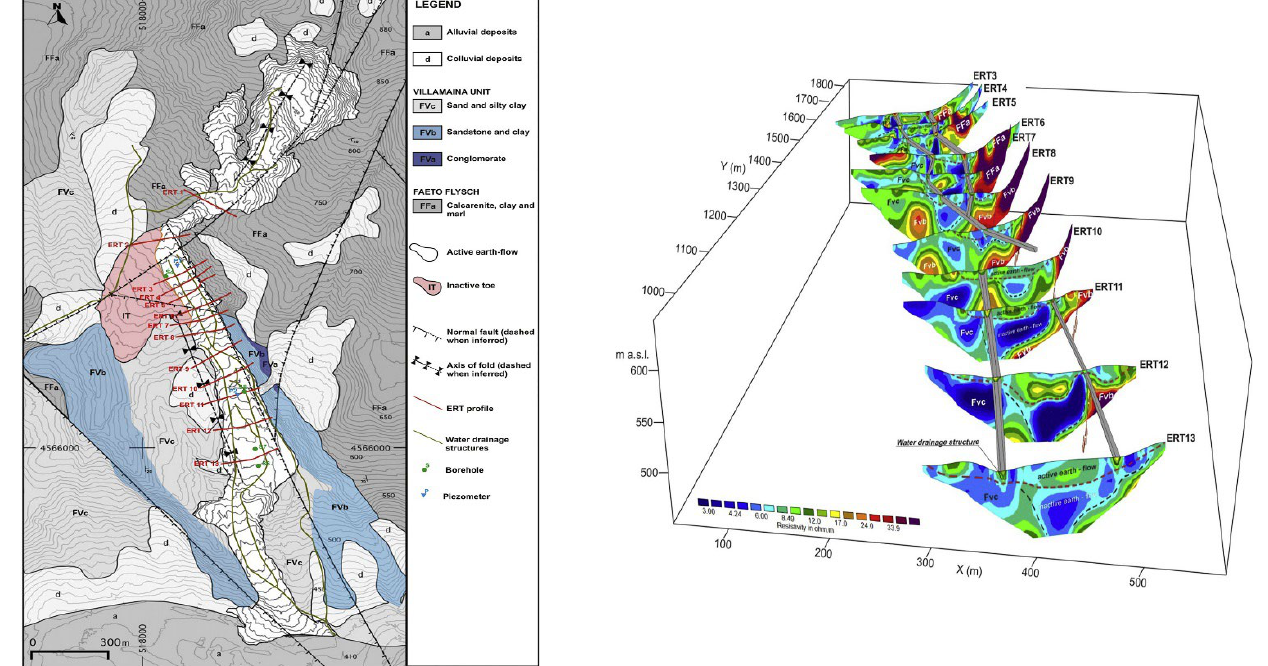
Figure 1. ( Left ) Geological map of the Montaguto earthflow (Campania region, southern Italy) with the location of direct and indirect investigations. Red lines: ERT profiles. Green line: water drainage structures. Green dot: borehole. Blue triangle: piezometers. ( Right ) Fence diagram showing the locations of the 2D ERT (ERT 3–ERT 13) within a 3D space. (Reprinted with permission from [7], Copyright (2018) Elsevier).